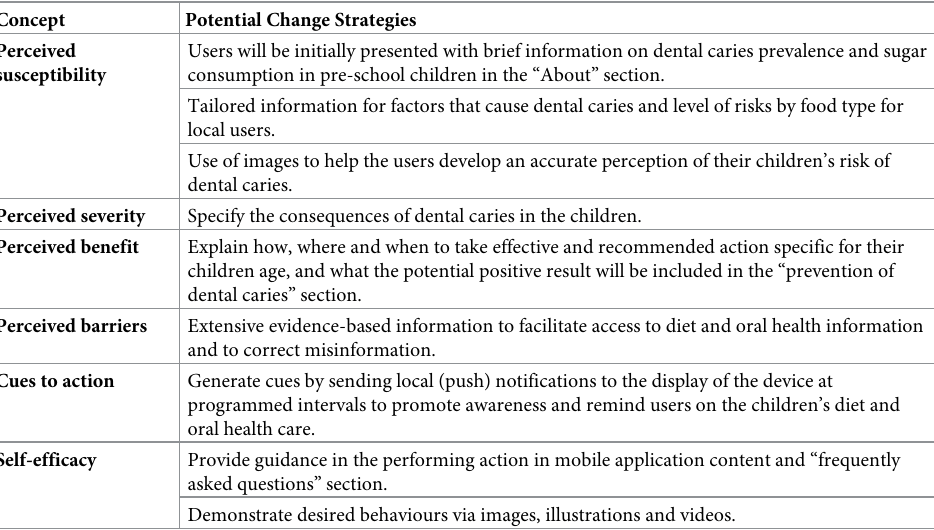
Table 1. Potential change strategies in Gigiku Sihat .